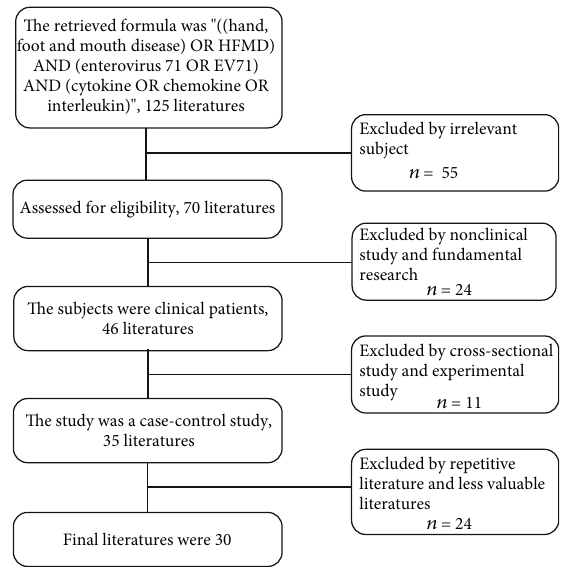
Figure 1: Study design and retrieval